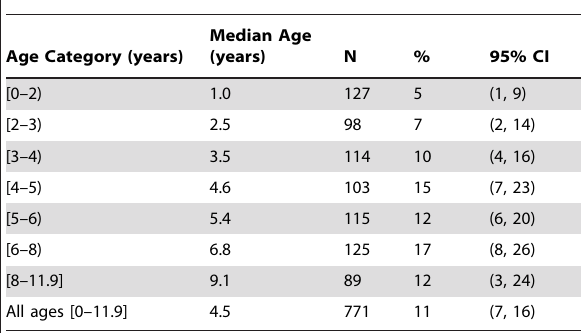
Table 1. Age-specific seroprevalence estimates based on the MSP-1 19 antibody measured in 142 children followed longitudinally in Le´ogaˆne, Haiti